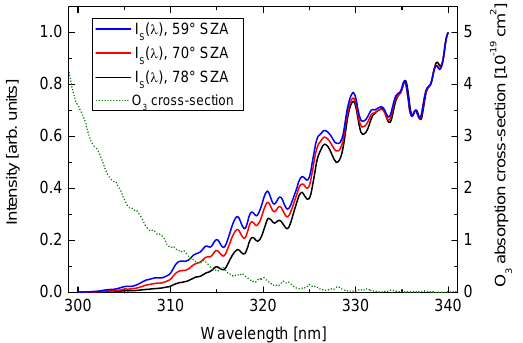
Figure 3. Measured spectra of scattered solar radiation I S ( λ ) for three different solar zenith angles (SZA). While an absolute calibration was not achieved (the quantum yield Q ( λ ) of the spectrometer is unknown), the intensity between 300 and 340 nm obviously increases relative to the intensity at 340 nm with decreasing solar zenith angle. This is caused by a decrease in optical path length of the detected radiation in the ozone layer. The ozone absorption cross-section (shown as dotted line) increases sharply towards lower wavelengths (Voigt et al., 2001, 223K).